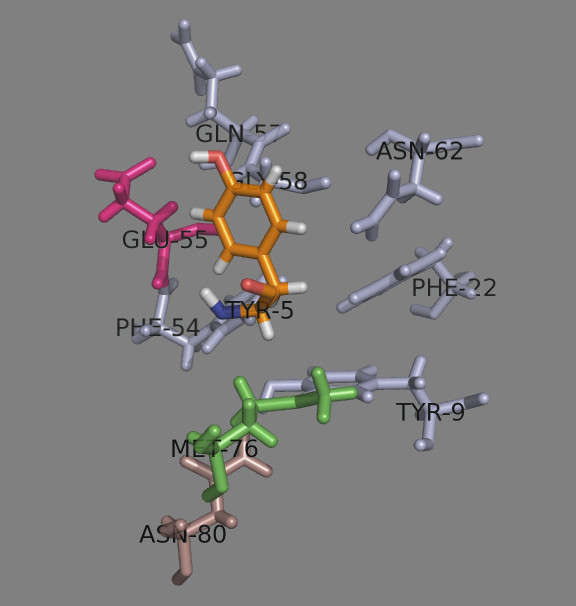
Peptide position 3. The α chain residues are shown in light blue, the β chain residues – in darksalmon. The dimorphic Met/Val76β is shown in green. Glu55α (given in magenta) makes a H-bond with p3 residue Tyr (given as TYR-5 in orange).